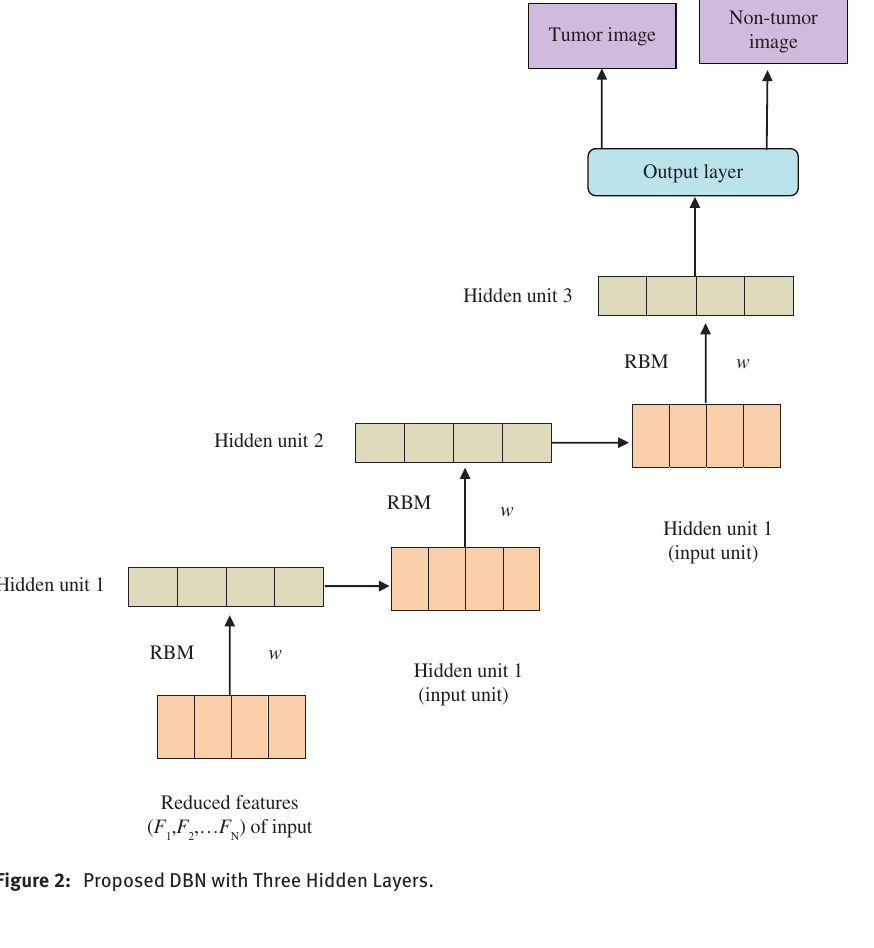
Figure 2: Proposed DBN with Three Hidden Layers.